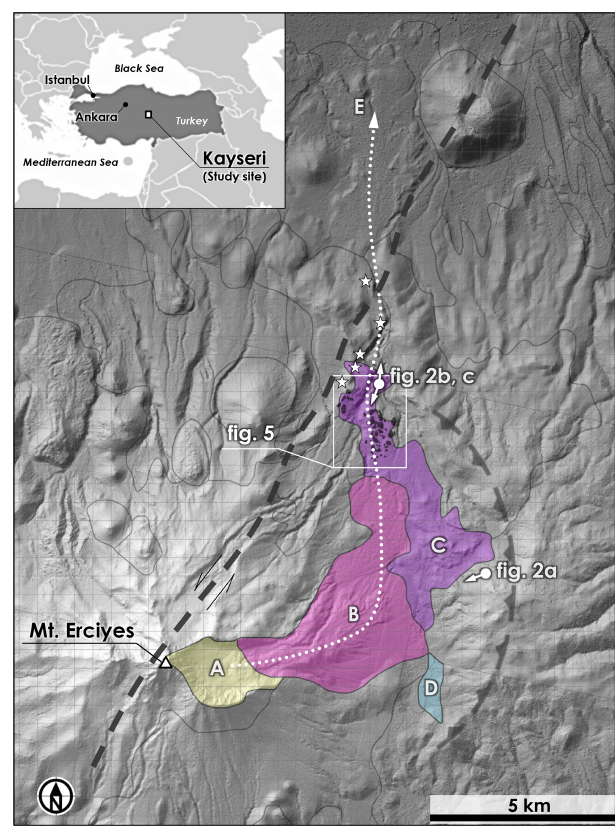
Figure 1. Map of the study area. A–E are different areas in DAD. A: source area; B: DAD; C: andesitic lava domes; D: lake area; E: flat lava terrain over which most of the debris went after exiting the narrow gorge. Dark polygons are hummocks; other polygons are other lithological units not affected by the avalanche. The dashed curving gray line with triangles indicates the remnant of caldera walls before the formation of the modern Mt. Erciyes. The Erciyes Fault is shown with the thick black dashed line as mapped by Emre et al. (2011). The stars indicate the locations of outcrops described in this study, and the dotted white arrow is the estimated course of the debris avalanche in this study. Note that the northern half of the lava domes (C) previously mapped by ¸Sen et al. (2003) is in fact the